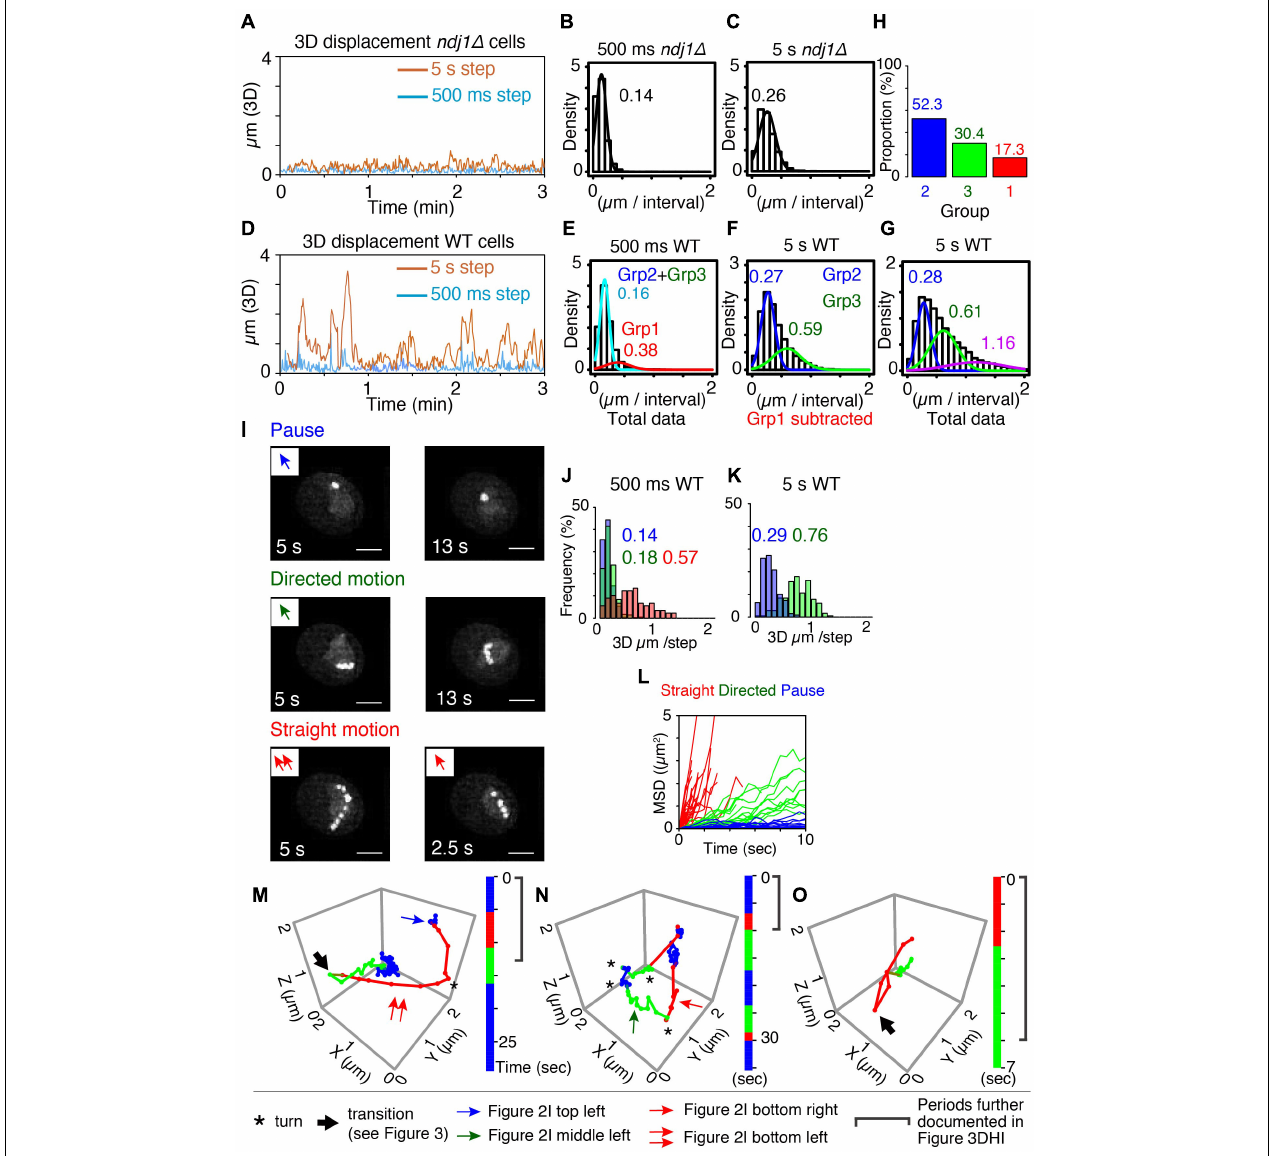
FIGURE 2 | Categorization of meiotic prophase telomere motion. (A) Representative 3D displacement pattern for 3 min with 500 ms step (turquoise) and 5 s step (orange) in ndj1 (cid:49) cells at t = 4 h. (B,C) Distribution of distances traveled (step size) over 500 ms ( B , mean = 0.14 µ m) and 5 s intervals ( C , mean = 0.26 µ m) plotted with Gaussian model in ndj1 (cid:49) cells at t = 4 h ( n = 10 cells). (D) Representative 3D displacement pattern for 3 min with 500 ms step (turquoise) and 5 s step (orange) in WT cells at t = 4 h (mid-prophase). (E–G) Distribution of distances traveled over 500 ms [ E , mean = 0.16 µ m (cyan, Group2+Group3) and 0.38 µ m (red, Group 1)], 5 s intervals [ F , mean = 0.27 µ m (blue, Group 2) and 0.59 µ m, (green. Group 3)], and 5 s intervals [ G , mean = 0.28 µ m (blue, Group 2), mean = 0.61 µ m (green, Group 3), and mean = 1.16 µ m (purple)] plotted with the two or three component Gaussian mixture model in wild type cells at = 4 h ( n = 17 cells). In (F) , the trajectories that include > 0.38 µ m/500 ms (Group 1) were eliminated. In (G) , the trajectories classified in purple include at least one step from Group 1 eliminated in (F) . (H) The proportion of the Group 1, 2, and 3 estimated from (E,F) . (I) The projection images of the totality of positions observed in the XY plane over the duration of the trajectory for these three types, “pause” (top), “directed motion” (middle), and “straight motion” (bottom) are illustrated. The scale bar is 2 µ m. Bottom left includes two continuous straight motion with the abrupt turn. (J–L) Comparison between distributions of distances traveled (step sizes) for the three types of mid-prophase motion over 500 ms (J) and 5 s intervals (K) . Comparison between MSD curves for the three types of prophase motion (L) ( n = 17 trajectories in pause, n = 18 trajectories in directed motion, n = 28 trajectories in straight motion from 7 cells). (M–O) Three representative series of trajectories for a tracked telomere locus at meiotic prophase ( t = 4 h). “Pause” = jiggling spot (blue). “Straight motion” = rapid motion in a straight/slightly curved trajectory (red). “Directed motion” = directional movement with a “zig-zag” path rather than a straight path (green). Vertical bars indicate the duration of each trajectory segment. Total imaging time represented was ∼ 30, 35, and 7 s, respectively. A single asterisk (*) indicates a sharp change in direction. A large arrow indicates transition of the motion (recoil motion) (see text). The blue arrow in (M) indicates the trajectory in (I) left top. The red arrow in (M,N) indicates the trajectory in (I) left bottom and right bottom, respectively. The green arrow in (N) indicates the trajectory in (I) left